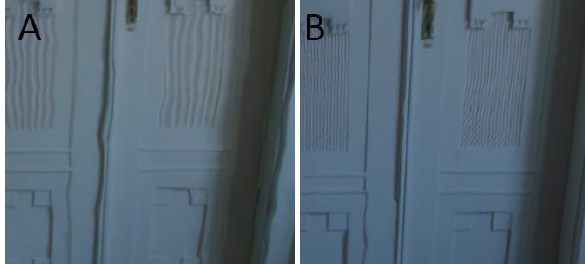
Figure 3. Comparison of adaptive orthophoto (A) and generic (B) textures mapped on mesh in Unreal Engine.